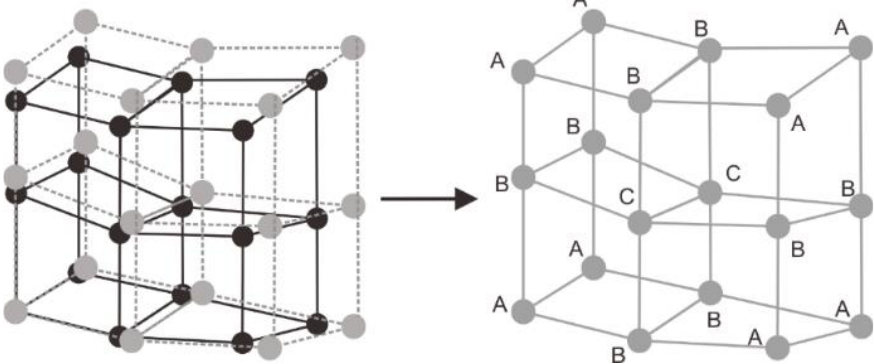
Figure 5. Reconstruction of grid cells and nodes involved in the 3D FE-to-CP grid transformation process.